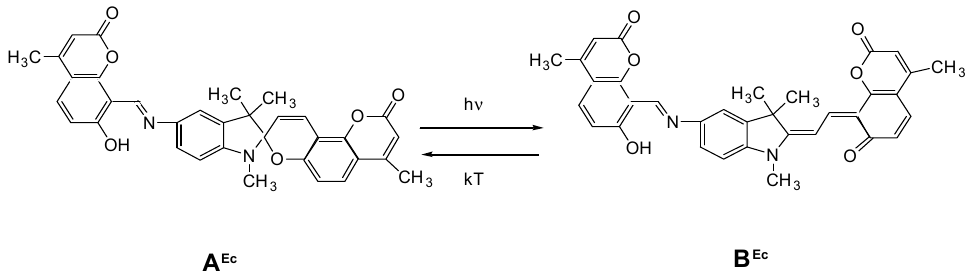
Scheme 13. Photochromic transformations of the hybrid compound 1 .